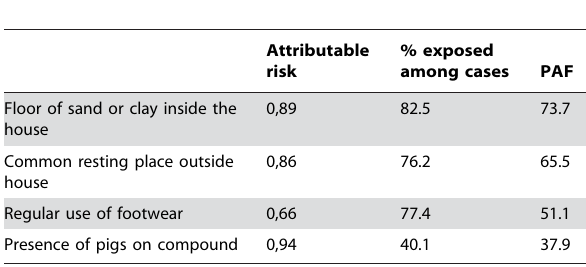
Table 3. Population attributable fractions of modifiable factors associated with